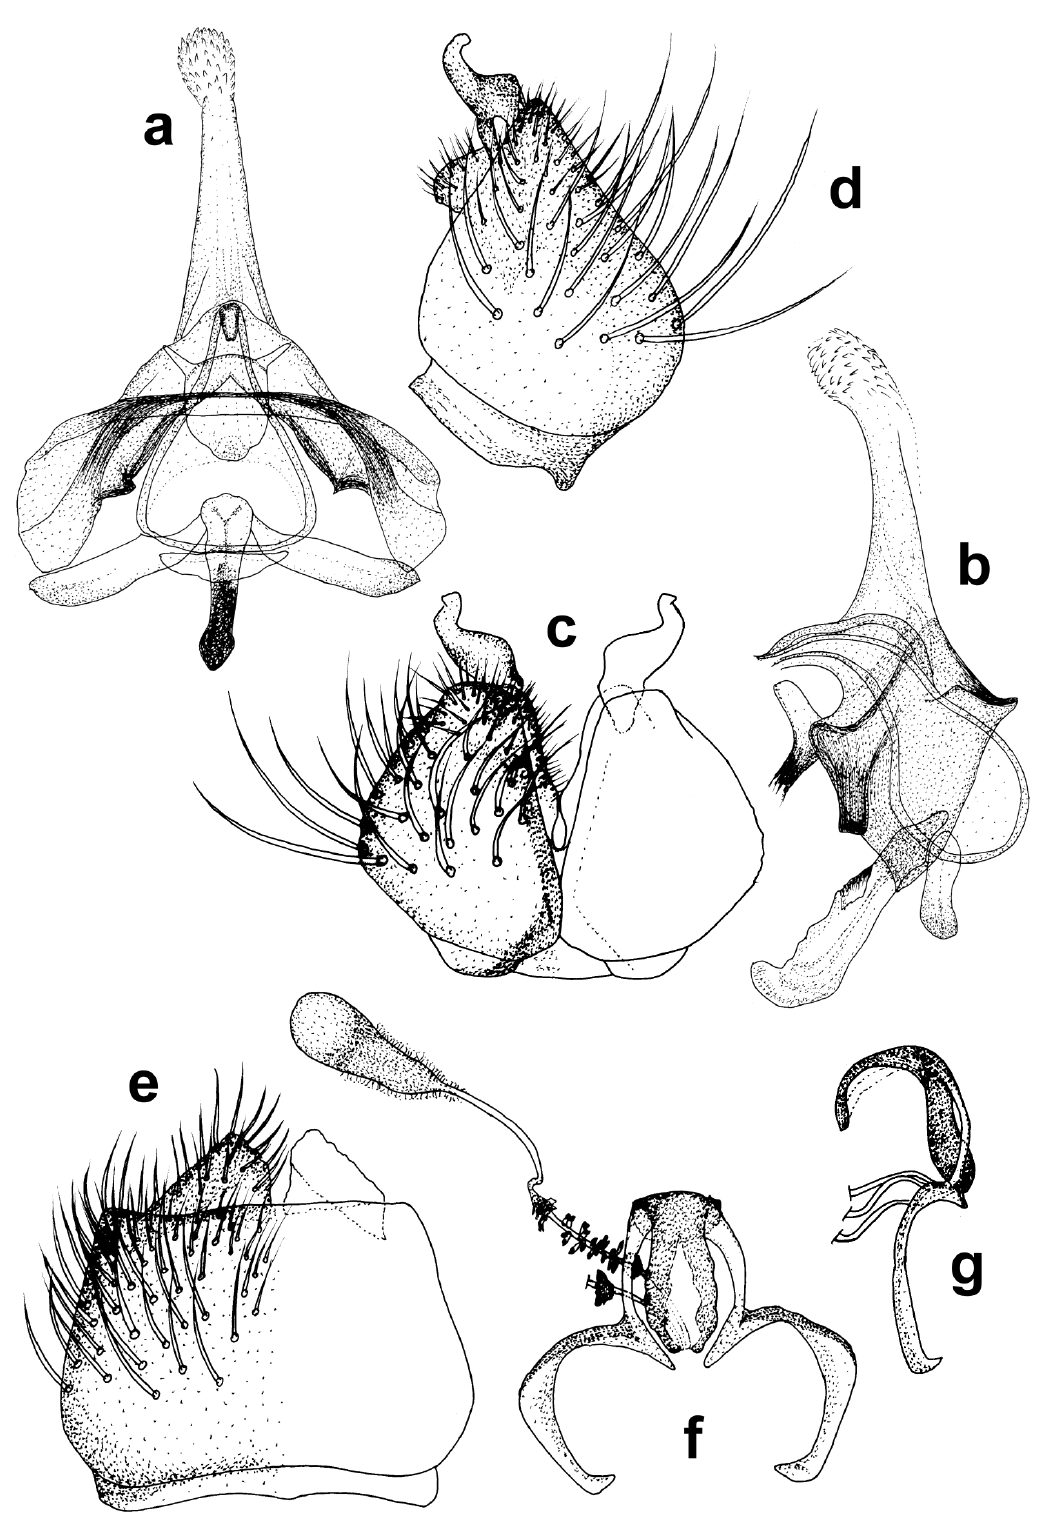
Fig. 53. Protypusia ornata (Engel, 1932) gen. et comb. nov. a . Epiphallic complex ventral. b . Epiphallic complex lateral. c . Gonocoxite ventral. d . Gonocoxite lateral. e . Epandrium dorsal. f . Female genitalia ventral. g . Female genitalia